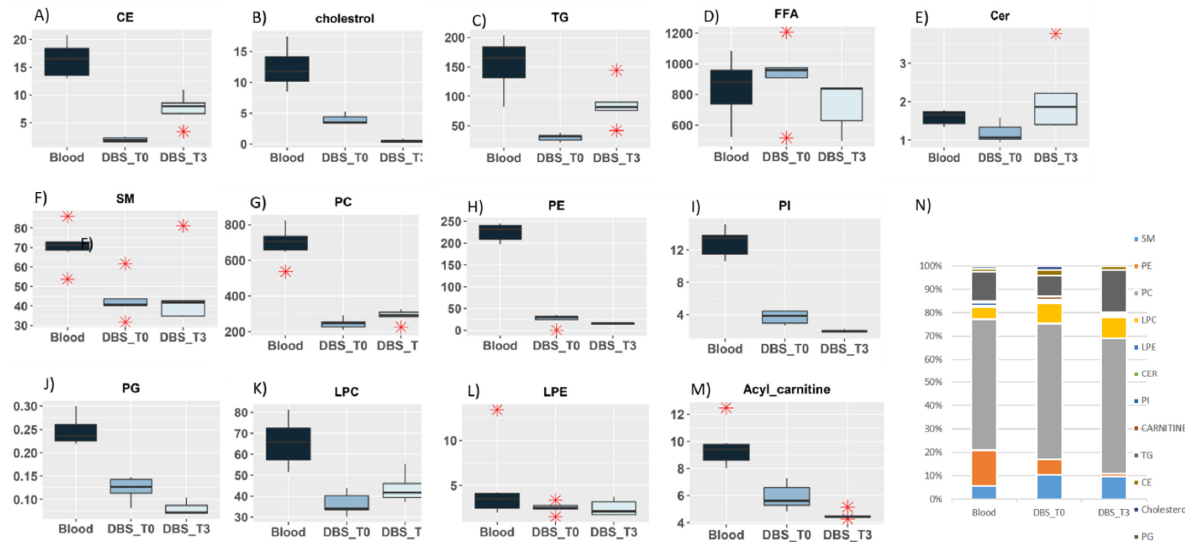
Figure 3. ( A – M ) Box-cum-whisker plots showing relative quantification for main lipid classes detected in Blood (dark blue), the Dry Blood Spot (DBS) T0 extracted the day of the deposit on blotting paper (medium blue) and DBS T3: 3 weeks after the day of deposit (light blue). In the box plots, the boxes denote interquartile ranges, horizontal line inside the box denote the median, and bottom and top boundaries of boxes are 25th and 75th percentiles, respectively. Lower and upper whiskers are 5th and 95th percentiles, respectively. ( N ) Histogram of % of lipid classes within the total lipids computed for Blood, Dry Blood Spot (DBS) T0 and Dry Blood Spot (DBS) T3 samples.